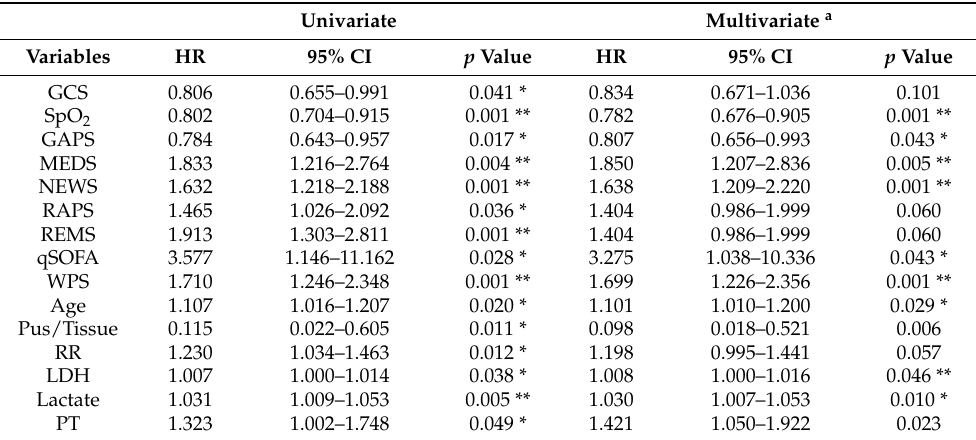
Table 8. The AUC of ROC, cut-off point, sensitivity specificity, positive predictive value (PPV), neg- ative predictive value (NPV), accuracy, and standard error (SE) of MEDS, NEWS, REMS, and GAPS to predict the mortality risk.